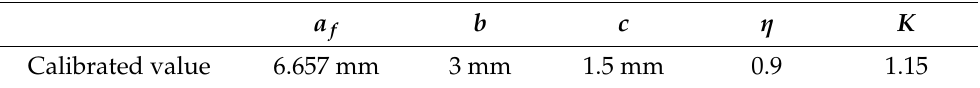
Table 2. Deterministic calibration of the unknown